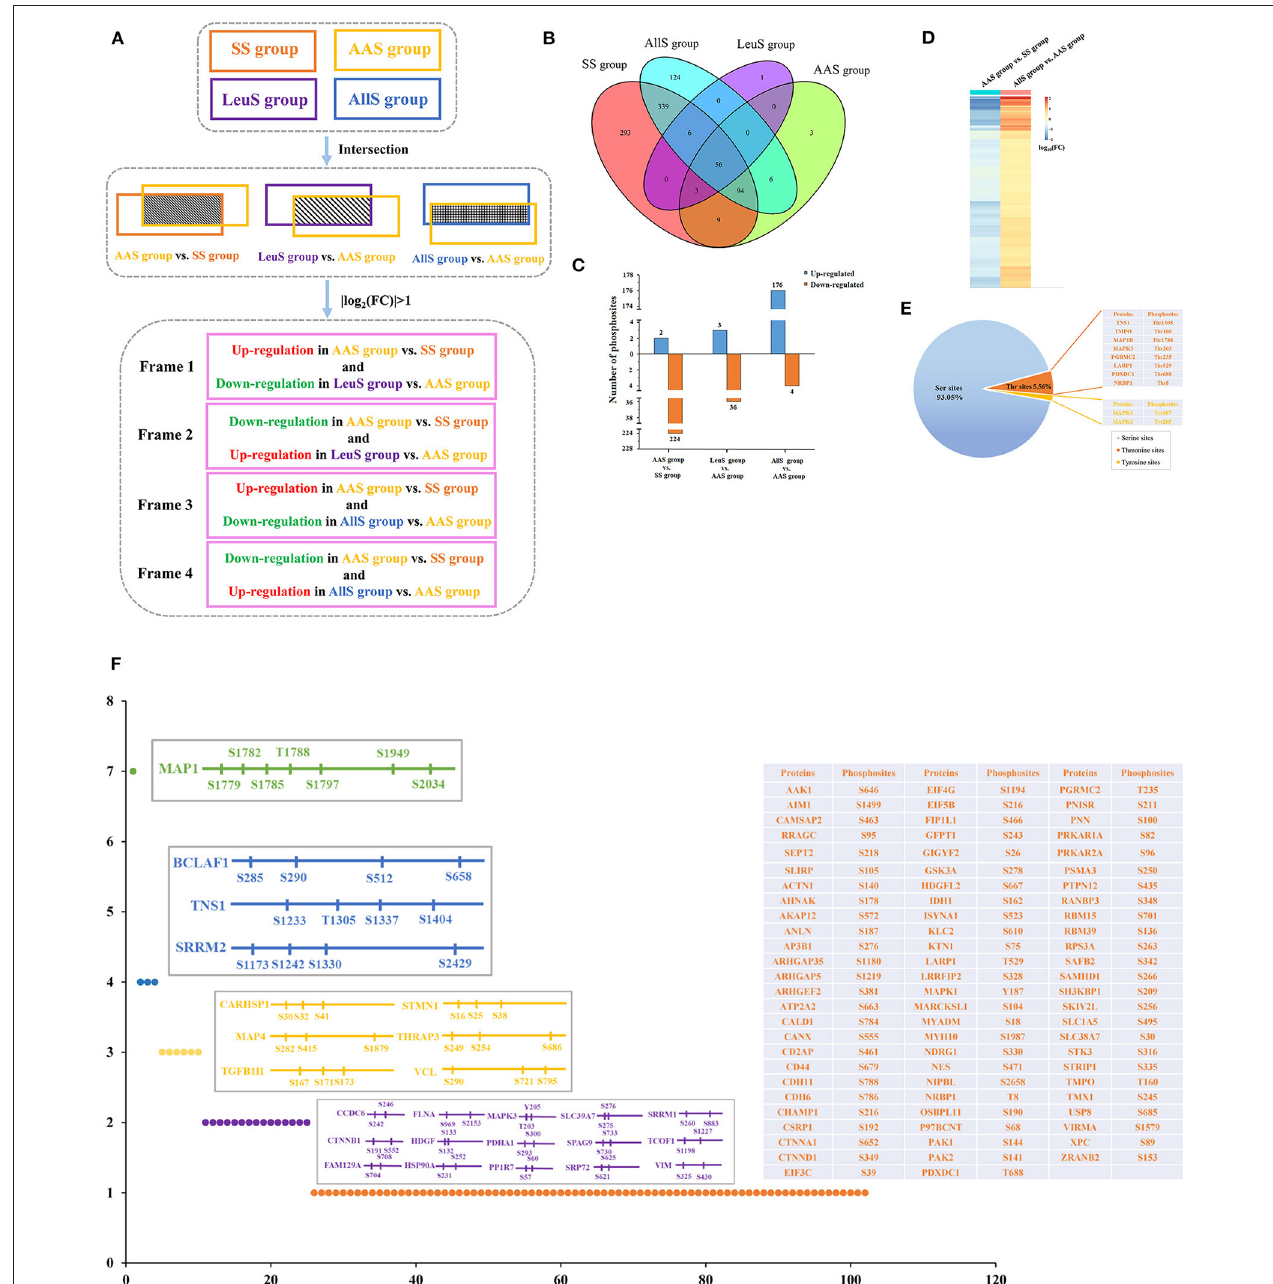
FIGURE 4 | Screening of phosphosites and phosphoproteins associated with amino acid signaling. (A) Concise schematic diagram of the screening process. The intersecting phosphosites between the SS and AAS groups, between the AAS and LeuS groups, and between the AAS and AllS groups were examined. Subsequently, |log 2 (FC)| > 1 was used as a filter, and changes in phosphorylation levels were compared between the AAS group vs. SS group and LeuS group vs. AAS group, as well as AAS group vs. SS group and AllS group vs. AAS groups, to obtain phosphosites in Frames 1–4. (B) The Venn diagram indicates that the number of proteins shared between the SS and AAS groups is 162, between the AAS and LeuS groups is 59, and between the AAS and AllS groups is 156. (C) The numbers of phosphosites that were upregulated in the comparisons AAS group vs. SS group, LeuS group vs. AAS group, and AllS group vs. AAS group were 2, 3, and 176, respectively. The numbers of phosphosites that were downregulated in the comparisons AAS group vs. SS group, LeuS group vs. AAS group, and AllS group vs. AAS group were 224, 36, and 4, respectively. (D) Heatmap, indicating the fold-changes in the phosphorylation abundance of phosphosites positively associated with the amino acid signals. The heatmap for the comparison AAS group vs. SS group shows declines in the phosphorylation levels after amino acid starvation, whereas the heatmap for the comparison AllS group vs. AAS group shows the increasing phosphorylation levels after restimulation with all amino acids. Blue represents a decrease in phosphorylation, whereas orange represents an increase in phosphorylation. Darker colors indicate greater fold changes. (E) The composition of phosphosites was positively associated with the amino acid signals. The proportions of serine, threonine, and tyrosine sites among all phosphosites were 93.05, 5.56, and 1.39%, respectively. (F) The distribution of phosphosites on proteins was positively associated with the amino acid signals. Most of the phosphosites were evenly distributed across different proteins. Only 15, 6, 3, and 1 protein featured 2, 3, 4, and 7 phosphosites,